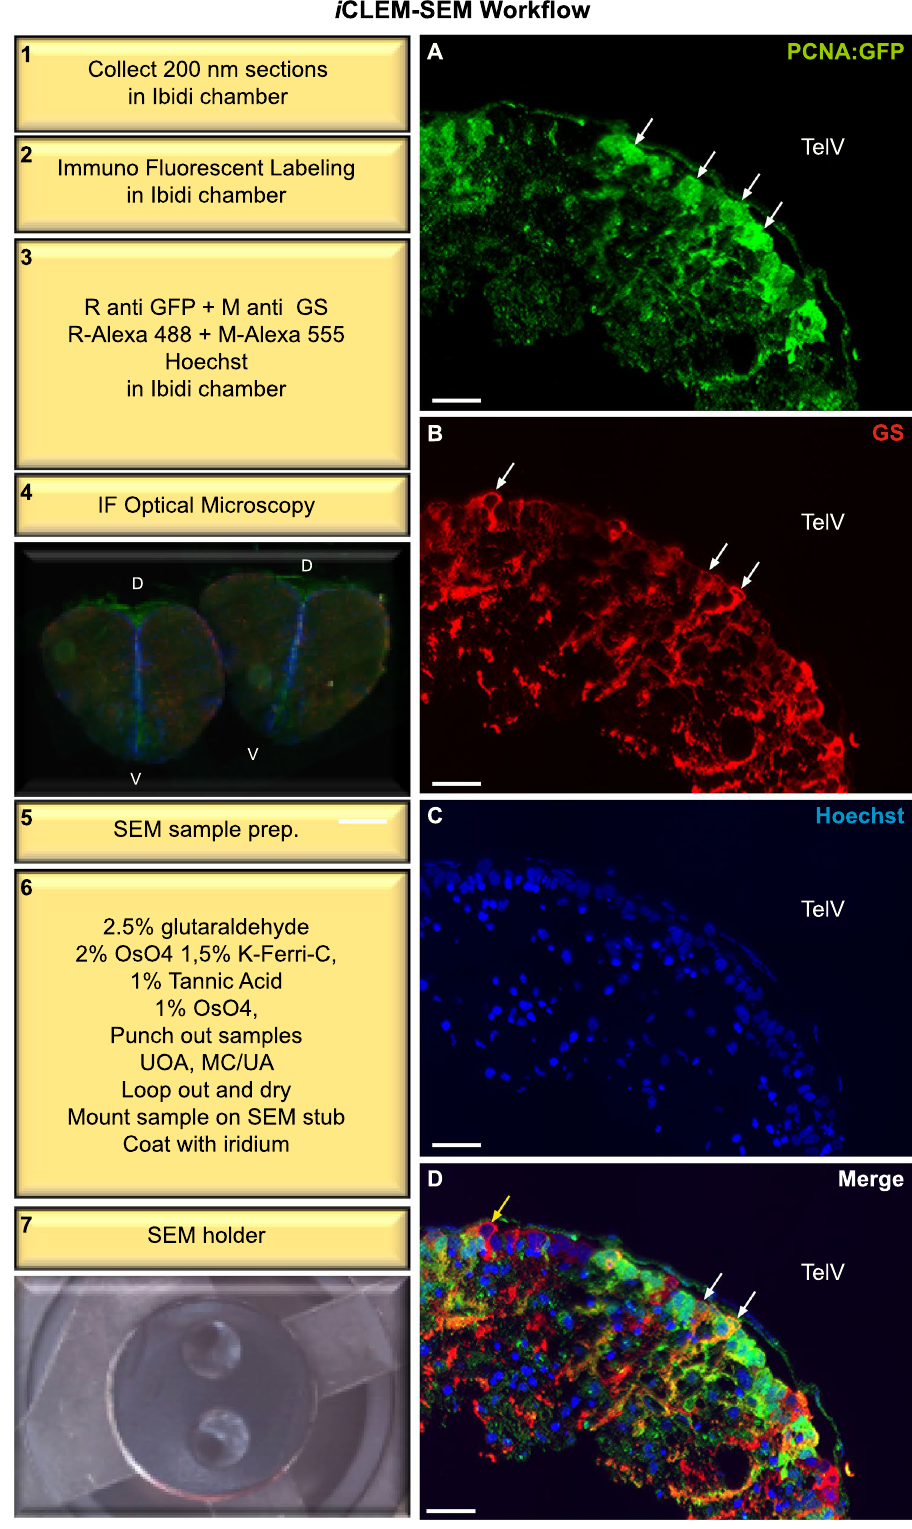
Figure 2. i CLEM-SEM workflow and immunofluorescent labelling on Tokuyasu chemical-fixed cryosections. Left: Major steps required for i CLEM-SEM workflow (steps 1–6). ( A ) Green Fluorescent Protein (GFP)-positive labelling ( green ) of proliferating cells from the Tg(PCNA:GFP) transgenic line (white arrows). ( B ) Glutamine Synthetase (GS)-positive labelling ( red ) of glial cells (white arrows). ( C ) Hoechst counterstaining ( blue ). ( D ) Multi-channel merge showing co-labelling of PCNA:GFP-positive cells with the glial marker ( orange cells; white arrows ) in the cytoplasm of a small number of cells. Differences in the intensity of antibody staining can additionally be noted (compare white arrows and yellow arrow). D dorsal; V ventral. TelV telencephalic ventricle. Scale bar ( A – D ) 20